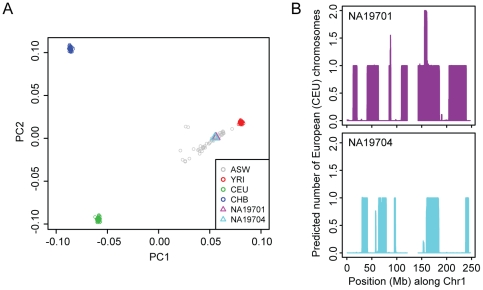
Global ancestry and local ancestry estimates.(A) The first two principal components (PCs), a measure of global ancestry, are plotted from the results of the genotype comparison of unrelated individuals in the four populations using EIGENSTRAT [37]. Two ASW individuals (NA19701 and NA19704) have similar PCs. (B) Shown are the predicted numbers of European chromosome copies, a measure of local ancestry, from the HAPMIX analysis [38] at each SNP locus for ASW individuals NA19701 and NA19704 at chromosome 1.